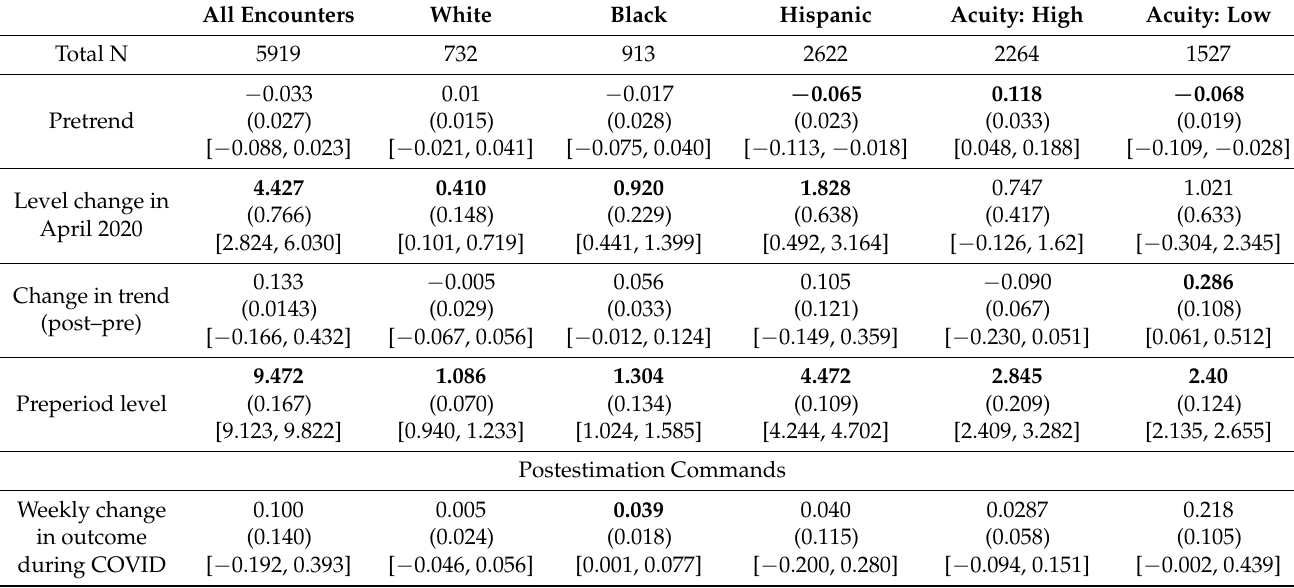
Table 2. Interrupted Time Series Results by Race/Ethnicity and Patient Acuity.